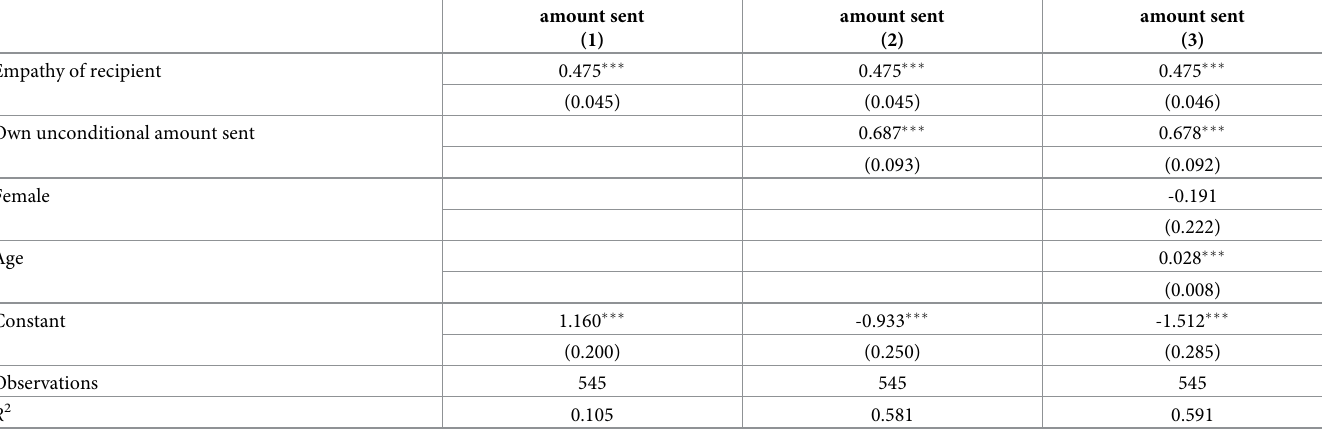
Table 3. Effect of the recipient’s empathy on prosocial behavior—Pooled OLS